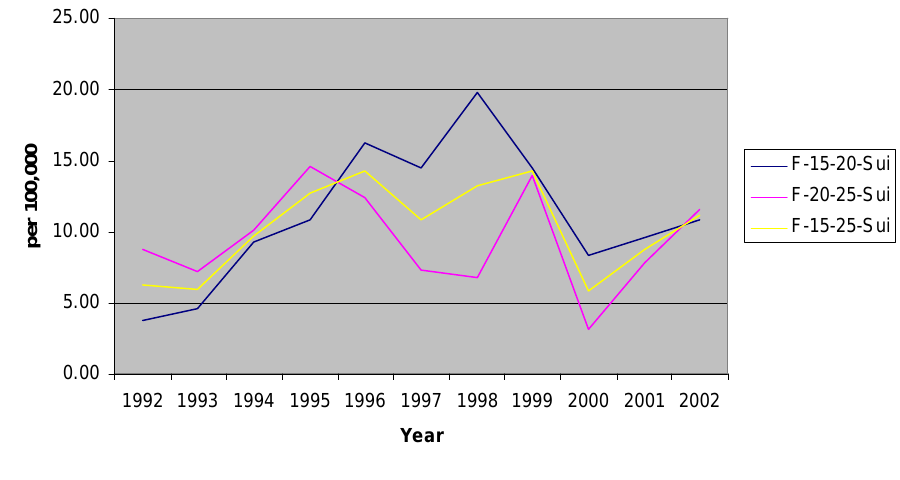
FIGURE 8. Youth suicide, females. Source: